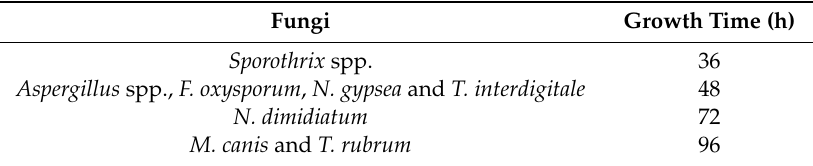
Table 2. Minimum growth times of different fungal taxa for protein extraction and reference spectra construction.